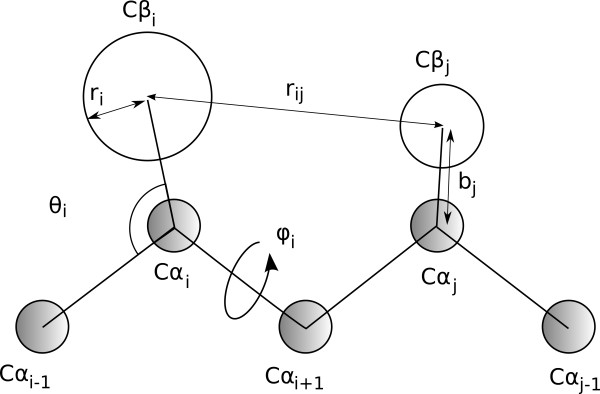
The two-bead model of protein structure is presented. Each residue consists of a Cα bead (grey) and a Cβ bead (white). Cα beads are placed at the position of the Cα atoms and form the backbone through being connected by virtual peptide bonds with a torsion angle φ. Each Cα bead (except Gly) binds a Cβ bead with a bond length b and bond angle θ. Cβ beads, whose centers reside at the geometric centroid of the residue atoms, are separated by a distance rij and have a radius ri (proportional to the radius of gyration of the side chain atoms).